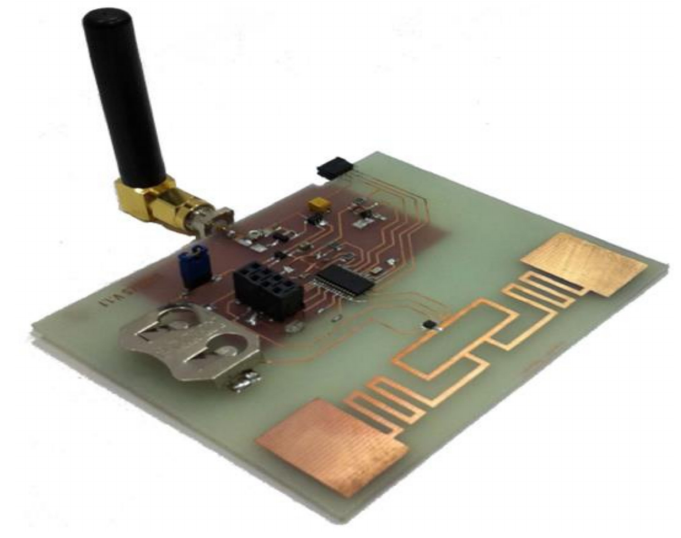
Figure 9. RAMSES Prototype